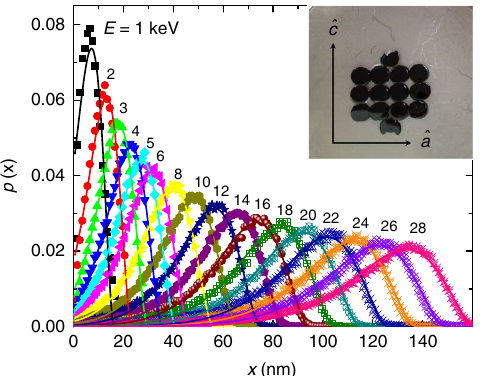
Fig. 4 Muon stopping pro fi les. The probability distribution p ( x ) of a muon to stop at some depth x inside the sample for different implantation